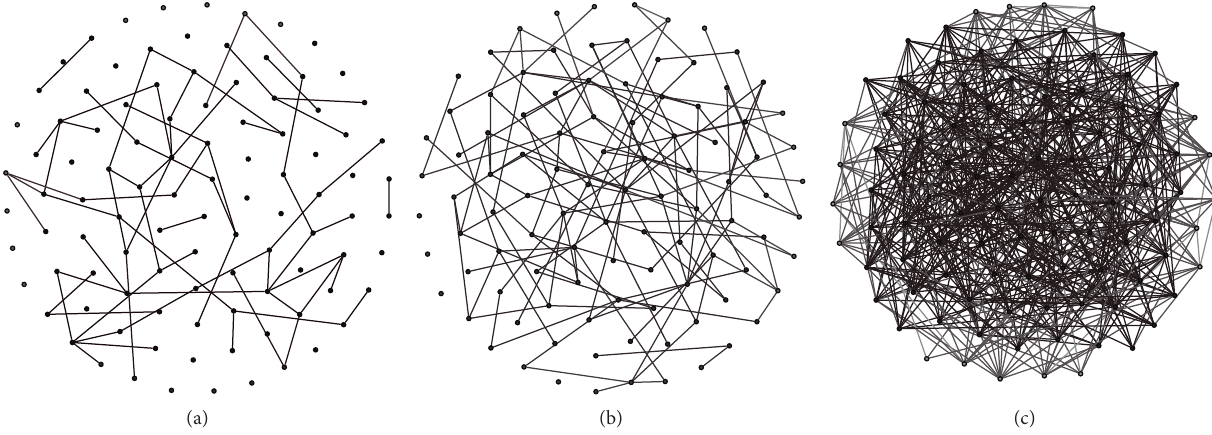
Figure 1: Network with different proportions of missing information: (a) more missing information, (b) less missing information, and (c) full